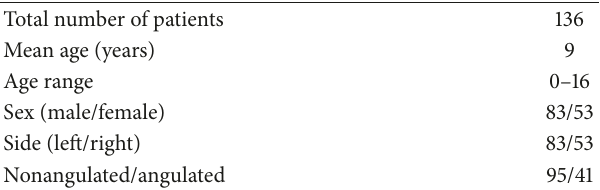
Table 1: Patient